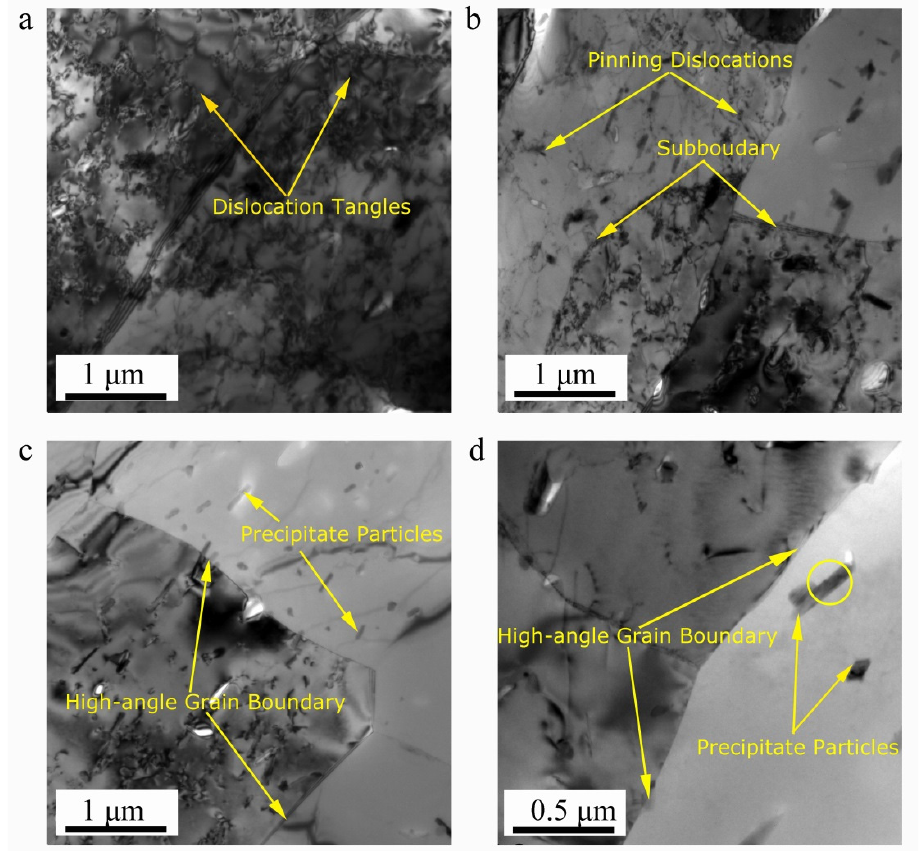
Figure 9. TEM micrographs of Al-Zn-Mg-Cu alloy in various deformation conditions: ( a ) 320 ◦ C / 1 s − 1 , ( b ) 380 ◦ C / 0.1 s − 1 , ( c ) 410 ◦ C / 0.1 s − 1 , ( d ) 440 ◦ C / 0.01 s − 1 .